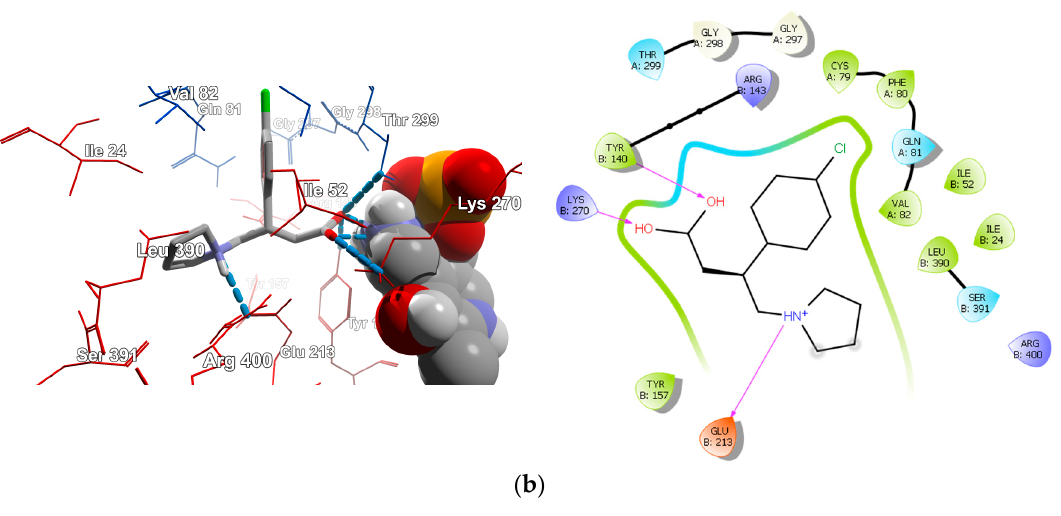
Figure 15. ( a ) (R) - 19a hydrogen bond interactions (blue dashed lines) with human GABA-AT; ( b ) (S) - 19a hydrogen bond interactions (blue dashed lines) with human GABA-AT. The PLP prosthetic group is shown as spacefill model. The images were made with Molegro programs.